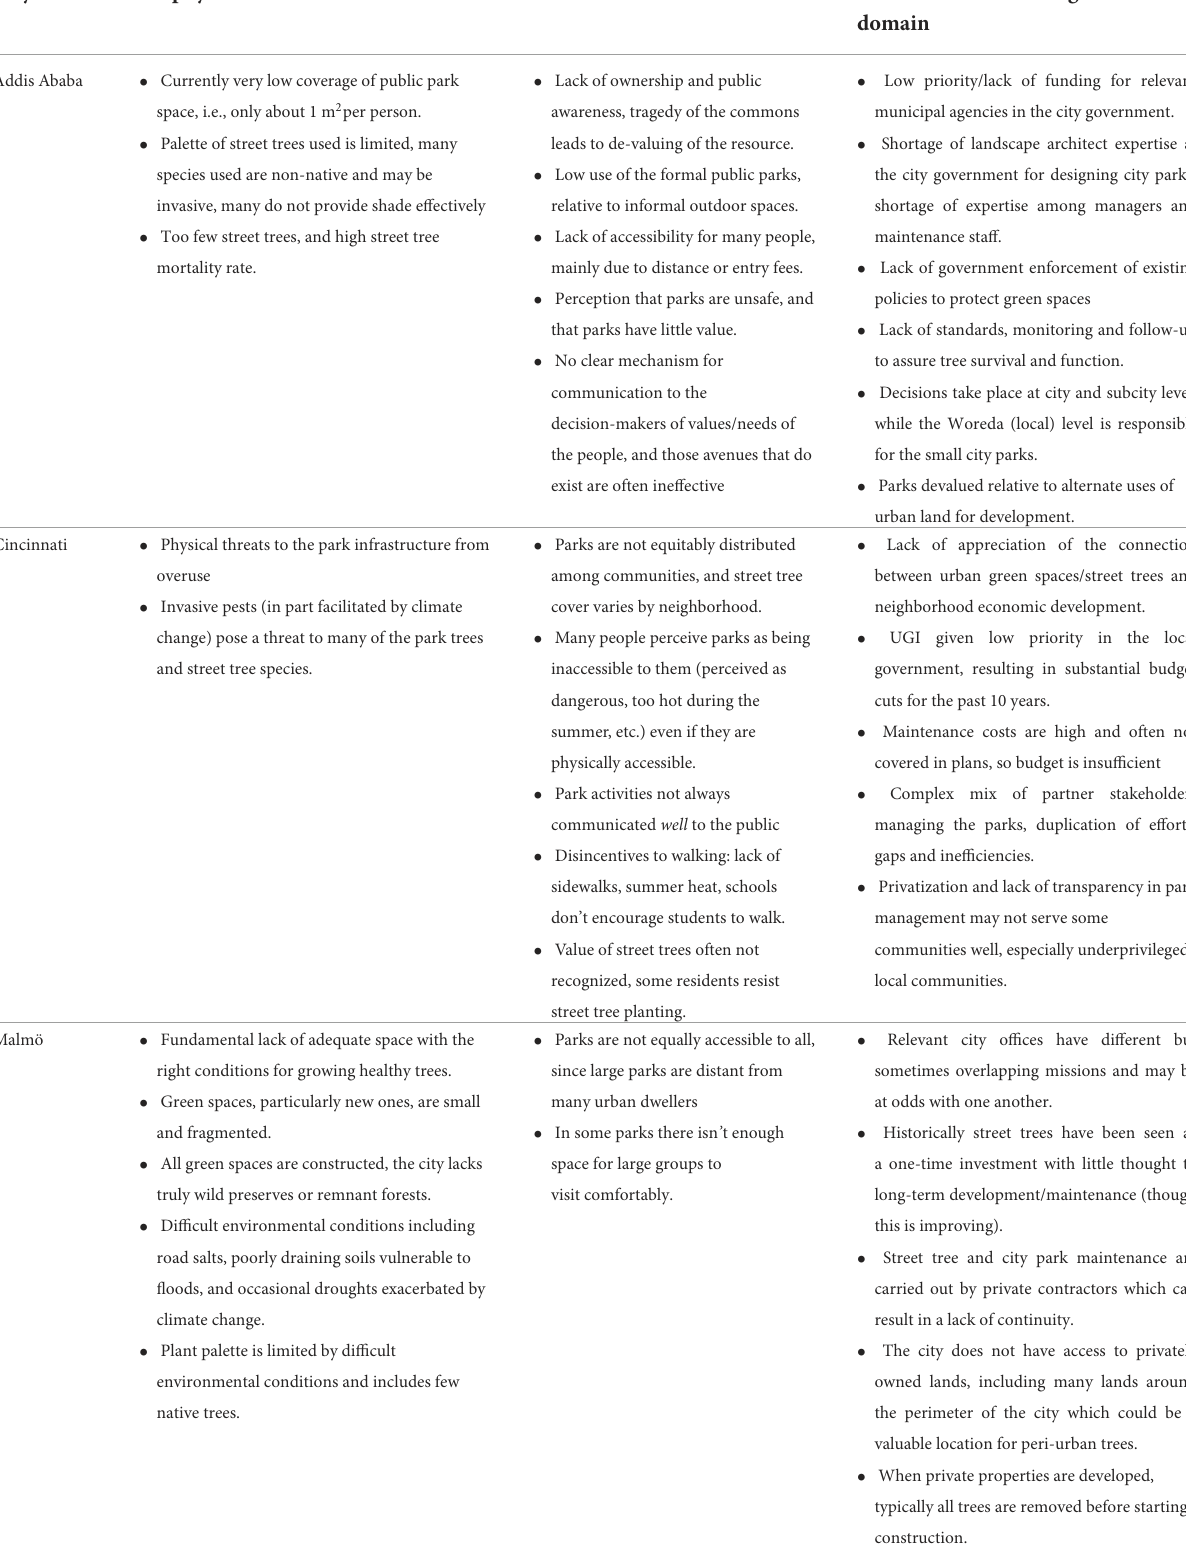
TABLE 4 List of challenges/barriers to successful ES provision by city parks and street trees, as emphasized by expert stakeholders in group interviews in each of three cities.